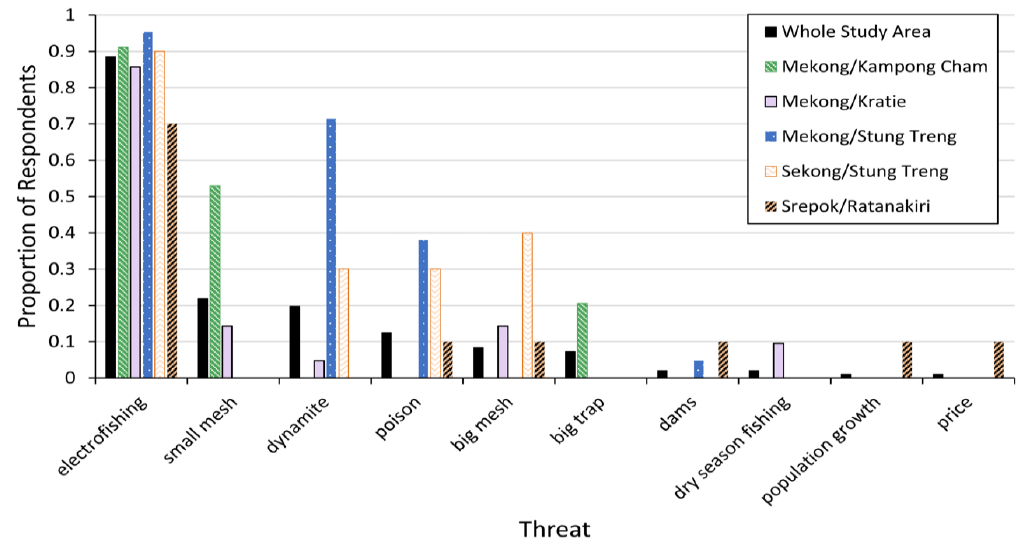
Figure 6. Threats to Mekong megafishes in northern Cambodia identified by local fishers. Bars show the proportion of fishers interviewed from each river section that named a given threat. Sample sizes are the total number of fishers interviewed in each river section in Table 2. Refer to the text for threat definitions. All of the fishing practices listed here are illegal in Cambodia.